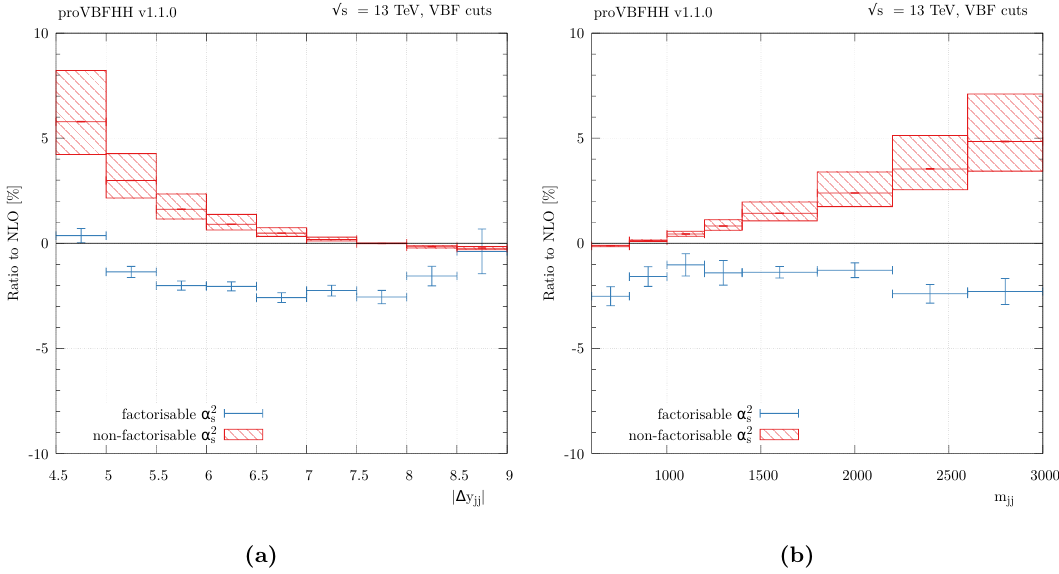
Figure 16. Same as (cid:12)gure 14 for (a) dijet rapidity separation (b) dijet invariant mass.